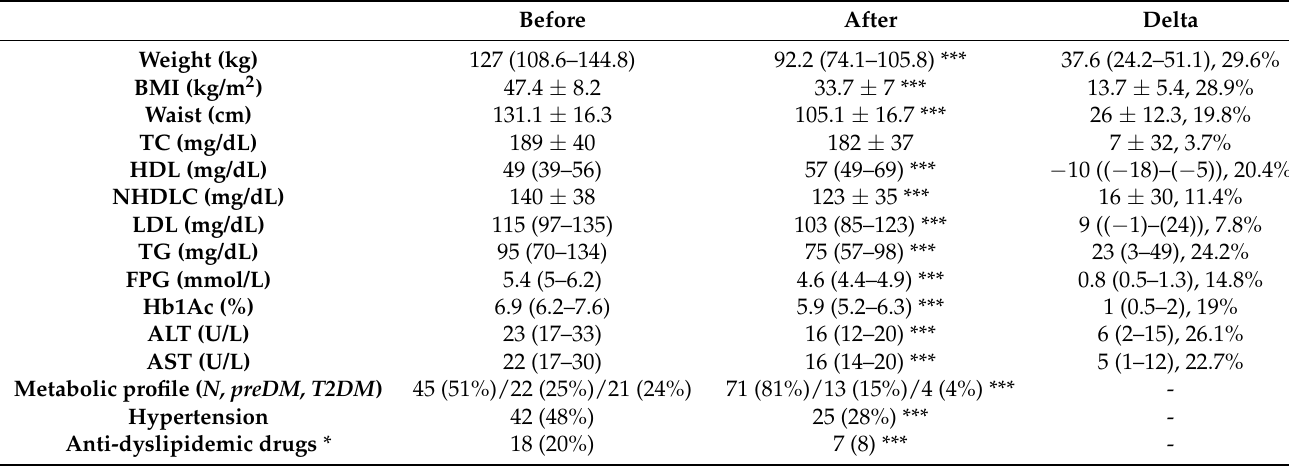
Table 2. Anthropometric, biochemical parameters and comorbidities change 18 months after laparoscopic sleeve gastrectomy in 88 patients.